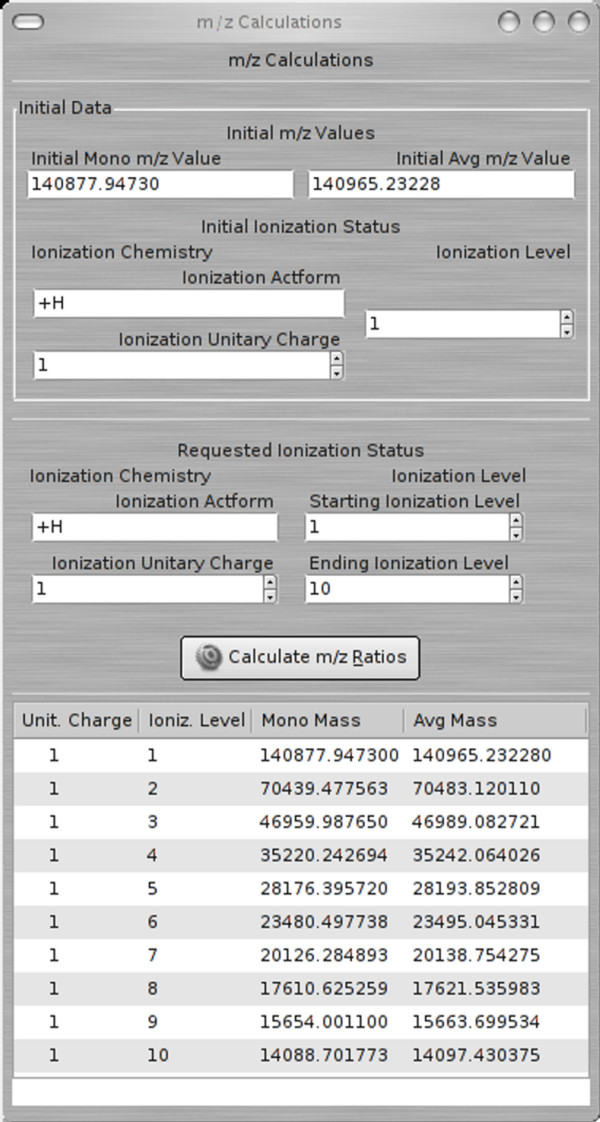
Mass-to-charge (m/z) ratio calculations. This figure shows how to perform m/z calculations starting from an analyte with a given m/z value for a given ionization agent (a proton, in our example). It is possible to ask for m/z ratios to be computed for any z value interval. Further, if the ionization has changed (by switching from protonation to cationization, for example), it is possible to stipulate the new ionization agent and its mass is taken into account for the calculation of the m/z values in the asked z range. The results are shown in the bottom part of the window.